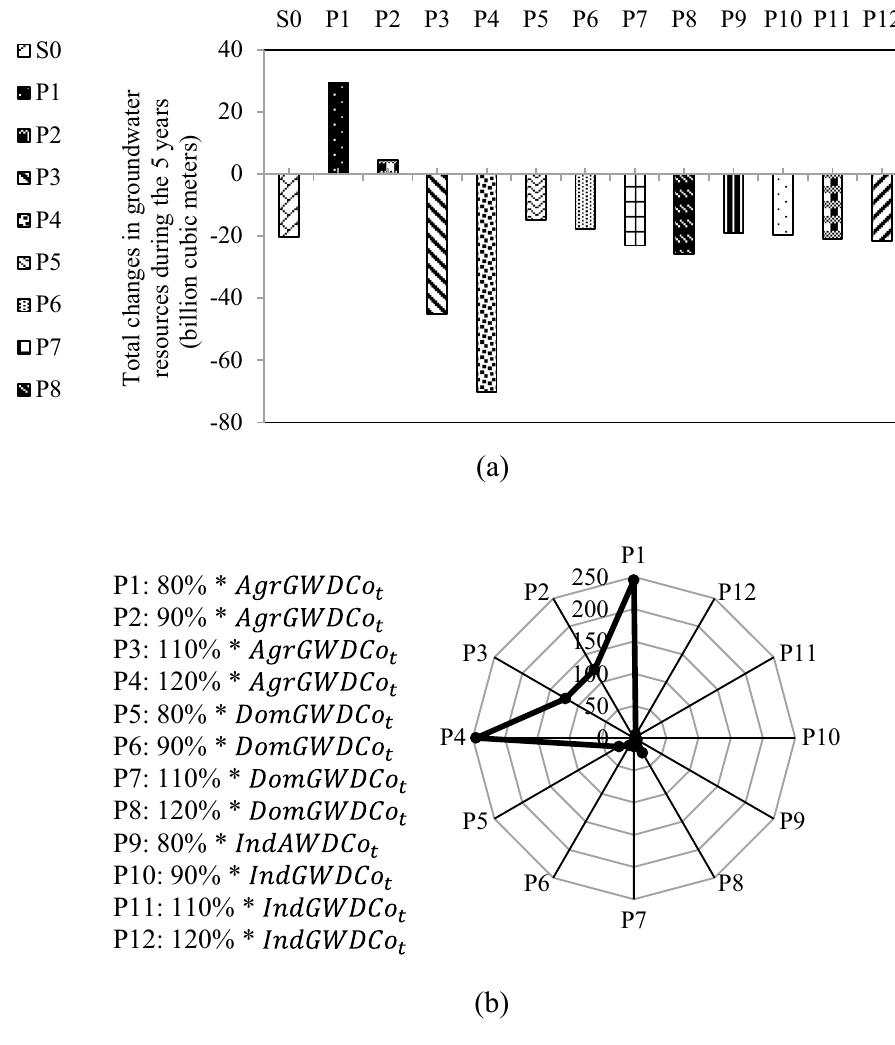
Figure 6. Sensitivity analysis: Impact of changes in the water supply coefficient from groundwater resources in different sectors on the balance of groundwater resources ( a ) In volume, and ( b ) In